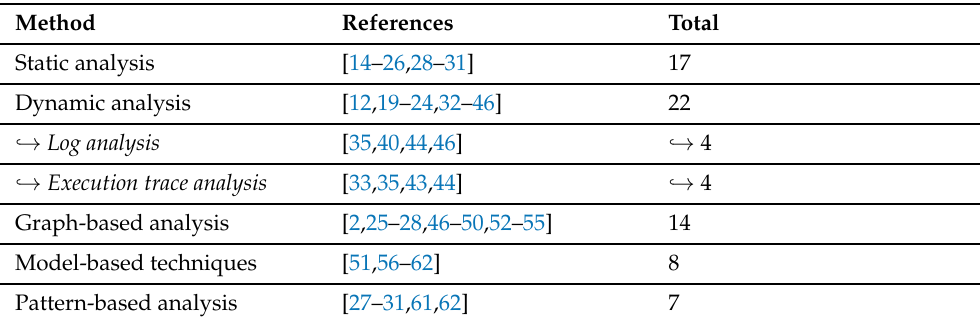
Table 5. Works relevant to